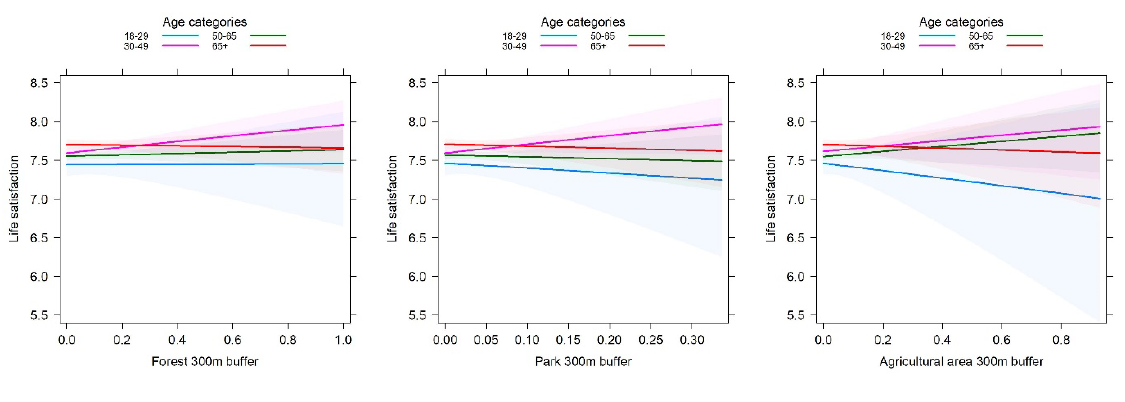
Figure S3 . Mutually adjusted greenspace associations with life satisfaction by age categories, adjusted for life satisfaction in the past, sex, household income, financial worries, canton, degree of urbanisation, and month of entry